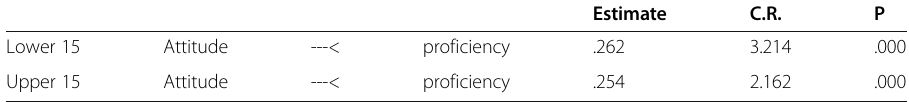
Table 11 Standardized Regression Weights:(Data-Default model) for work experience of participants Estimate C.R. P Lower 15 Attitude ---< proficiency .262 3.214 .000 Upper 15 Attitude ---< proficiency .254